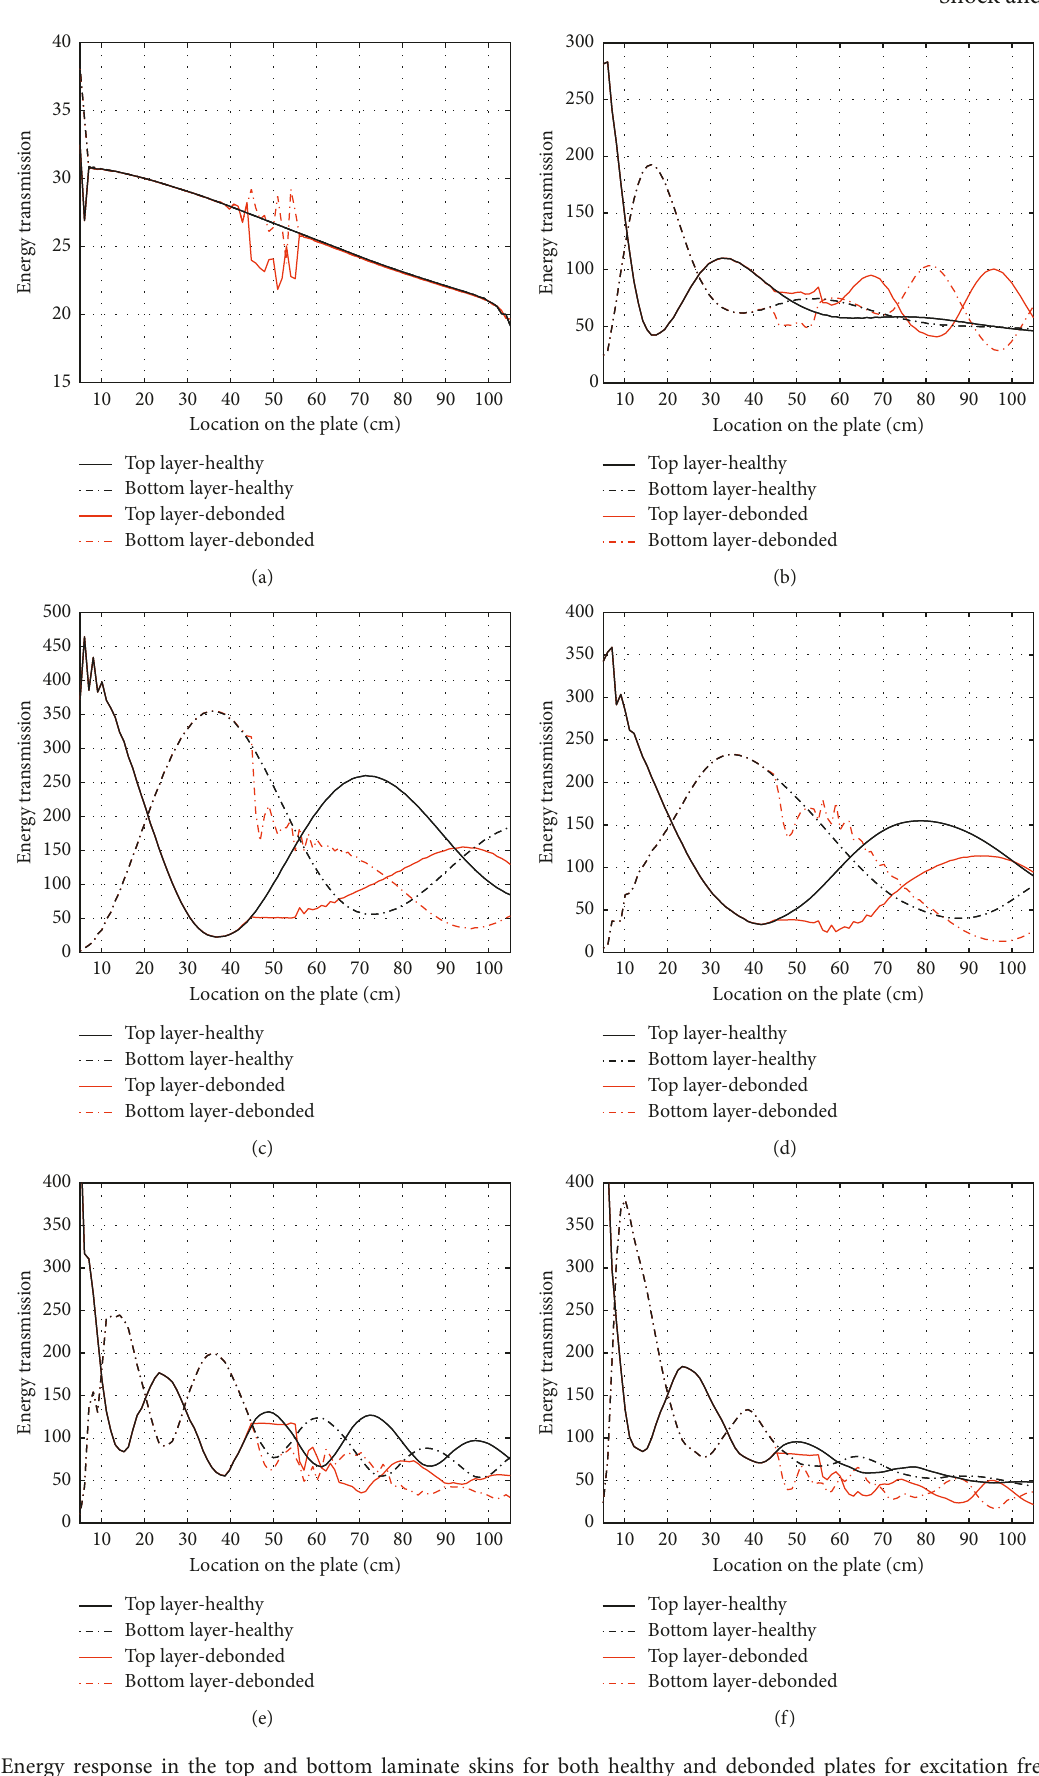
Figure 5: Energy response in the top and bottom laminate skins for both healthy and debonded plates for excitation frequencies of (a) 15kHz, (b) 40kHz, (c) 60kHz, (d) 80kHz, (e) 100kHz, and (f)